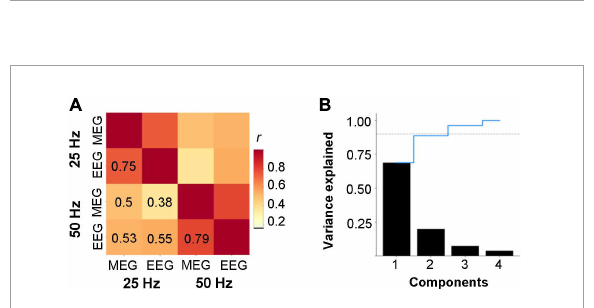
FIGURE6 Population-wide properties of the ITC measures among the two modalities (MEG and EEG) and two response components (25 and 50 Hz). (A) Correlation matrix depicting the relationships between each modality’s and response frequency’s ITC measures. (B) Percentage of variance explained by each principal component. The dashed line shows the cumulative variance ratio explained. The dotted horizontal line indicates 0.9 level of variance explained, for reference.